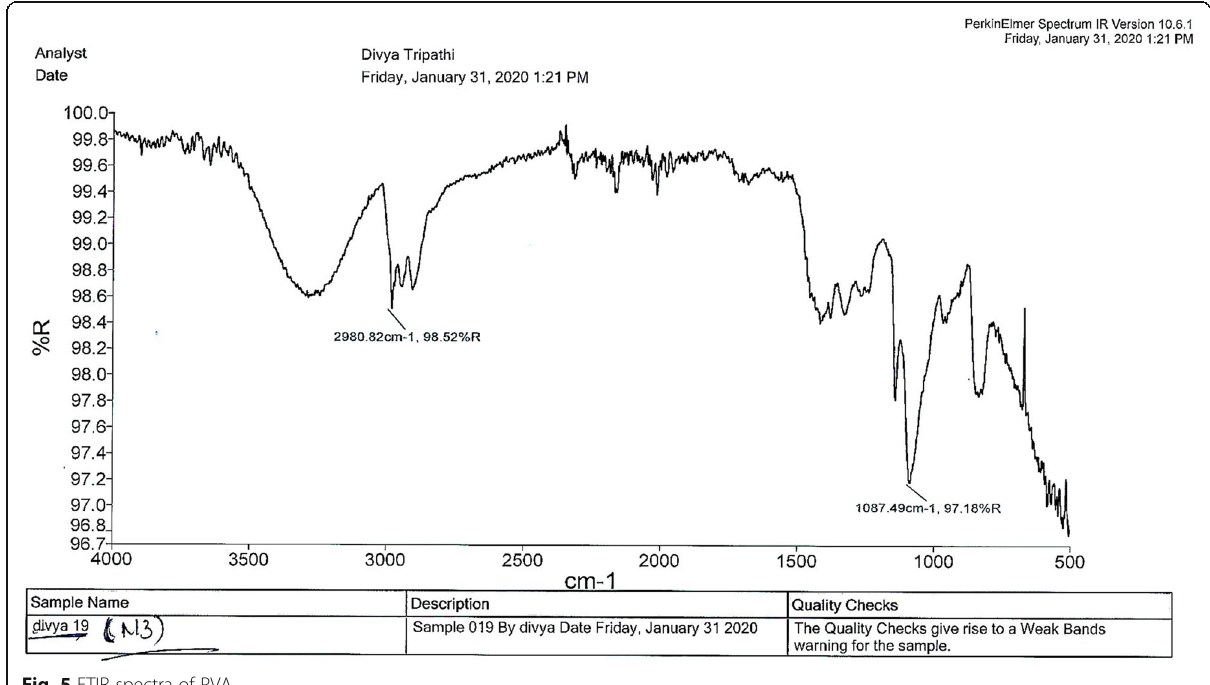
Fig. 5 FTIR spectra of PVA